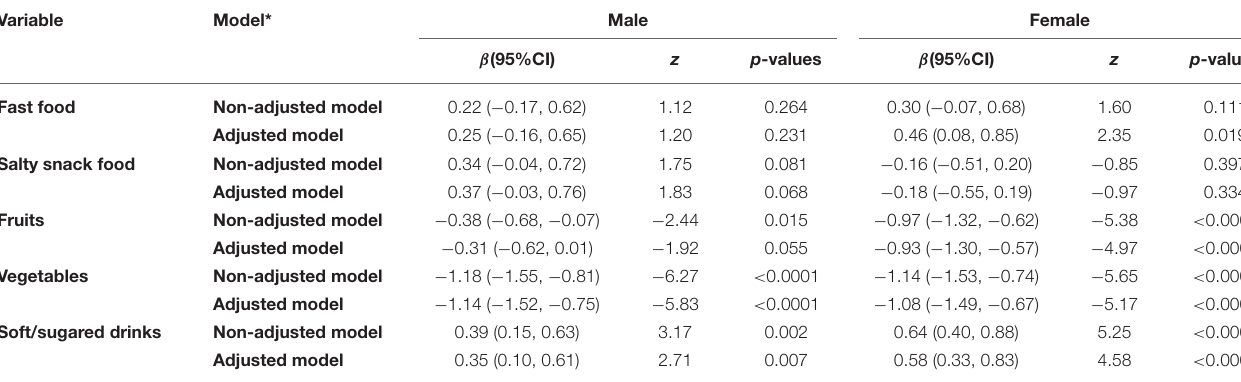
TABLE 4 | Associations between PSS-14 scores and Each Variable of Food Preference in Male and Female. Variable